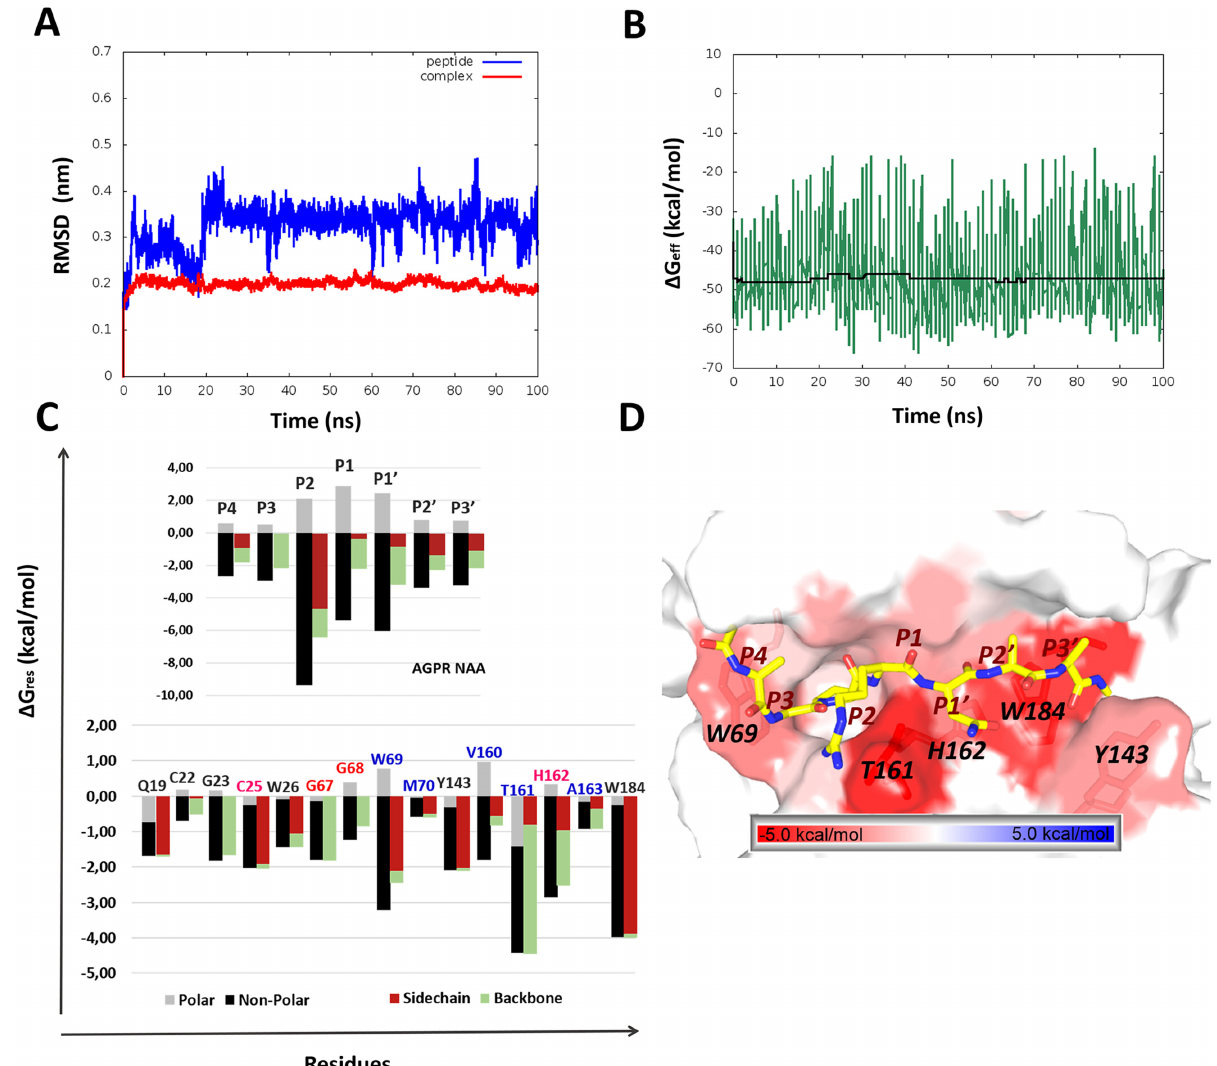
Fig 1. Stability assessment and per-residue free energy decomposition for the FhCL3-peptide complex. (A) RMSD values relative to the initial structure calculated for the backbone atoms of the peptide (blue) and the FhCL3-substrate complex (red)during the simulation time. (B) Effective binding free energy (green) and accumulated mean (black) values versus simulation time. (C) Per-residue free energy values for key residues of the FhCL3-peptide complex. Bars are split into backbone, side chain, polar and non-polar contributions. Residue names are colored according to the enzyme ’ s subsite location, i.e. S1 in pink, S2 in blue and S3 in red. (D) Structural representation of FhCL3 hot-spots according to per-residue energy contribution values onto the average structure of the